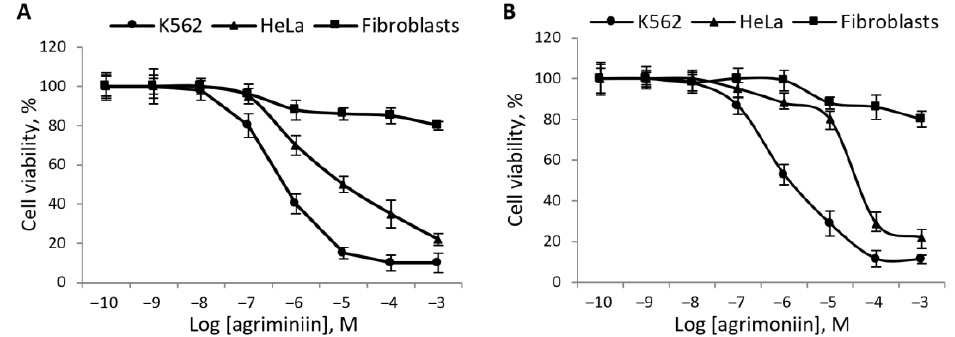
Figure 7. Influence of agrimoniin on the viability of cancer cells and fibroblasts. Cells of cancer lines HeLa and K562, and rat skin fibroblasts were incubated during 48 h ( A ) and 72 h ( B ) with agrimoniin at concentrations from 10 − 10 to 10 − 3 M. The viability of cells was assessed by the MTT test and presented in % of reference values. The data given represent the average values from five